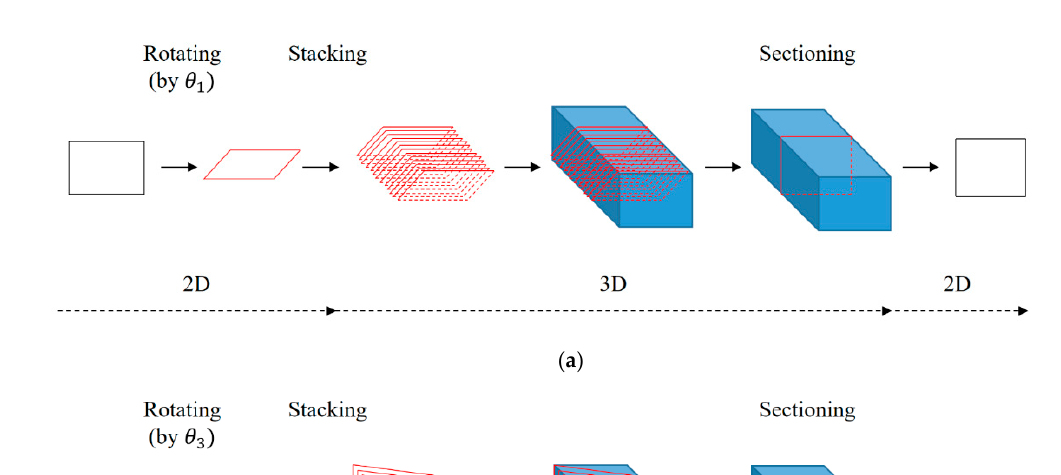
Figure 7. Calibration process for the ( a ) X w and ( b ) Z w rotation errors.